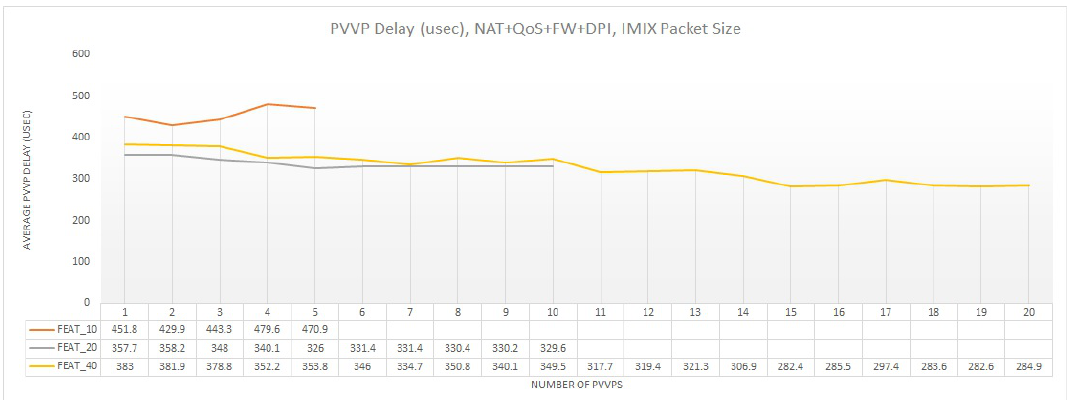
Figure 17. Multi-Feature multi-PVVP average delay with NAT, QoS, FW, and